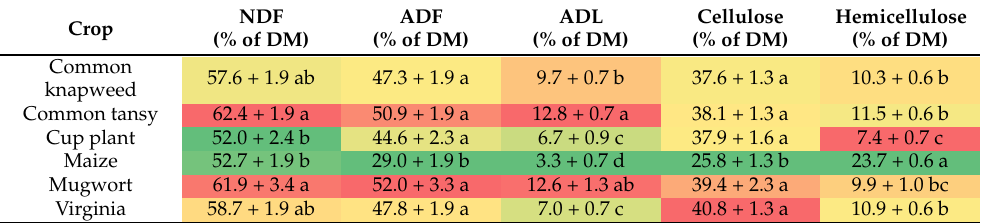
Table 2. Lignocellulosic composition of the biogas crops (sorted alphabetically) investigated in this study. Additionally, the standard error is provided. The color scaling indicates per parameter the meaning of the value for the use of biomass as biogas substrate from good (dark green) to bad (deep red). NDF ADF ADL Cellulose Hemicellulose Crop (% of DM) (% of DM) (% of DM) (% of DM) (% of DM) Common knapweed